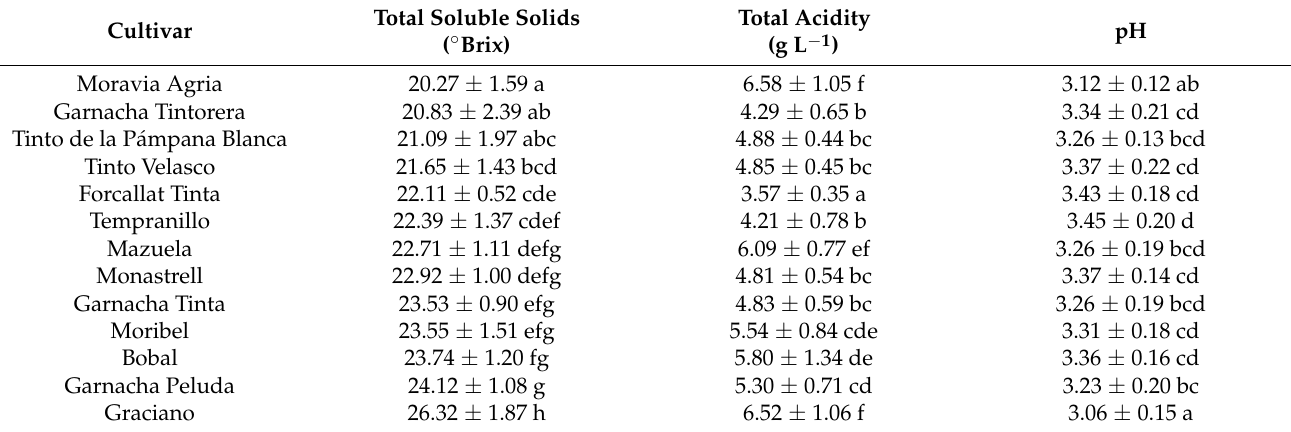
Table 2. Must quality components (mean value ± standard deviation, n = 15) of 13 red cultivars.